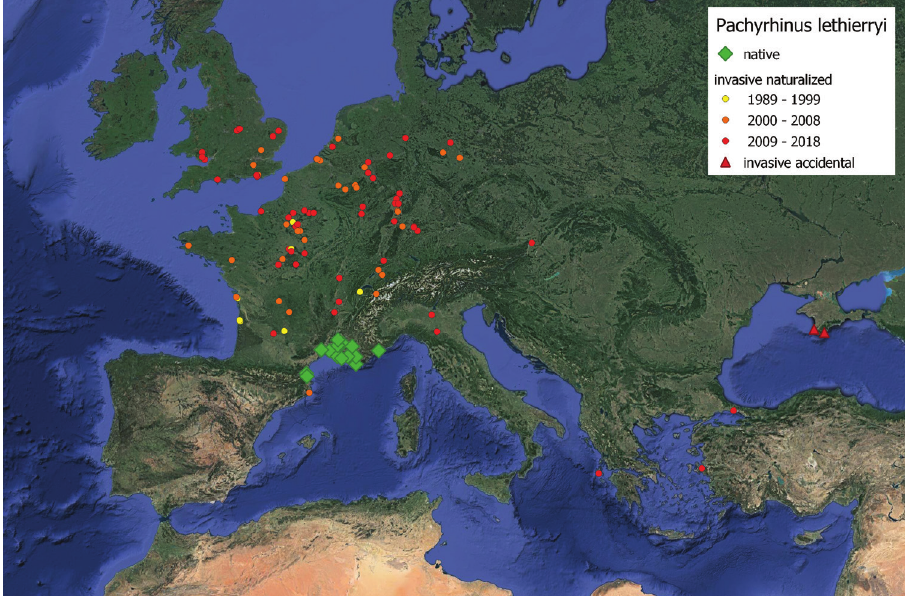
Figure 4. Occurrence pattern of Pachyrhinus lethierryi . The yellow through orange to red gradient indi- cates the chronology of invasion from 1989 to